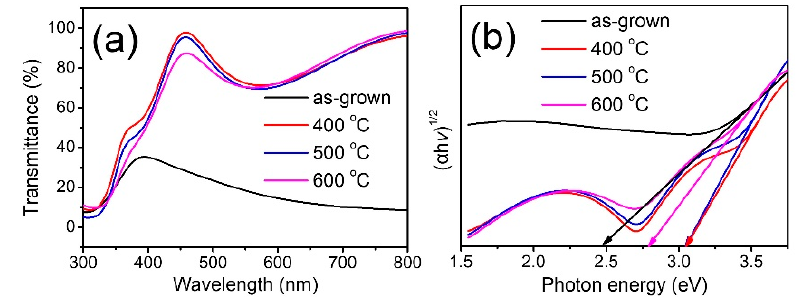
Figure 7. ( a ) Optical transmittance spectra of various WO 3 films, ( b ) Tauc plot of various WO 3 films.